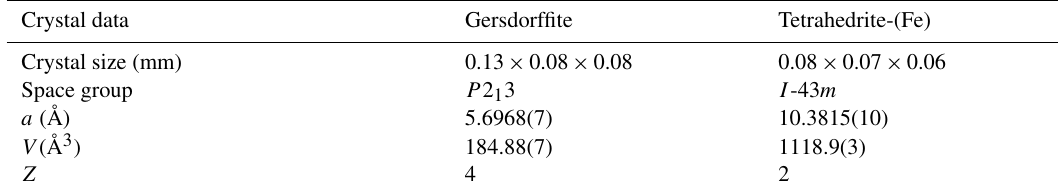
Table 3. Summary of parameters describing data collection and refinement for gersdorffite and tetrahedrite-(Fe). Crystal data